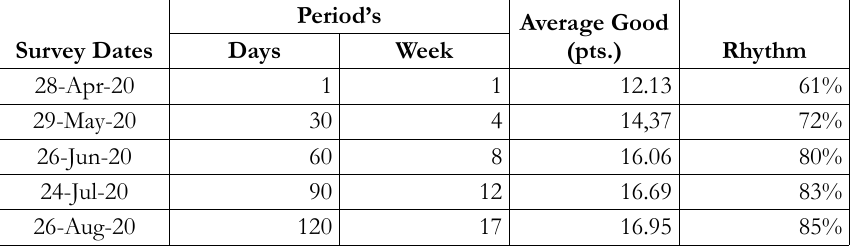
Table 5. Measurement schedule of the series of surveys – Own source